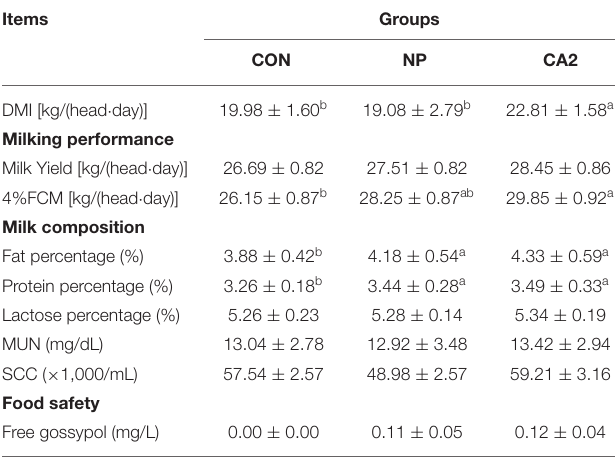
TABLE 5 | Effects of processed WCS on dry matter intake, milking performance, and milk composition. Items Groups